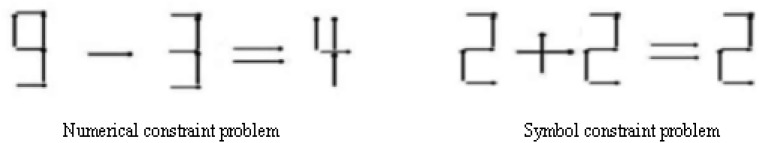
Matchstick arithmetic problems type diagram.